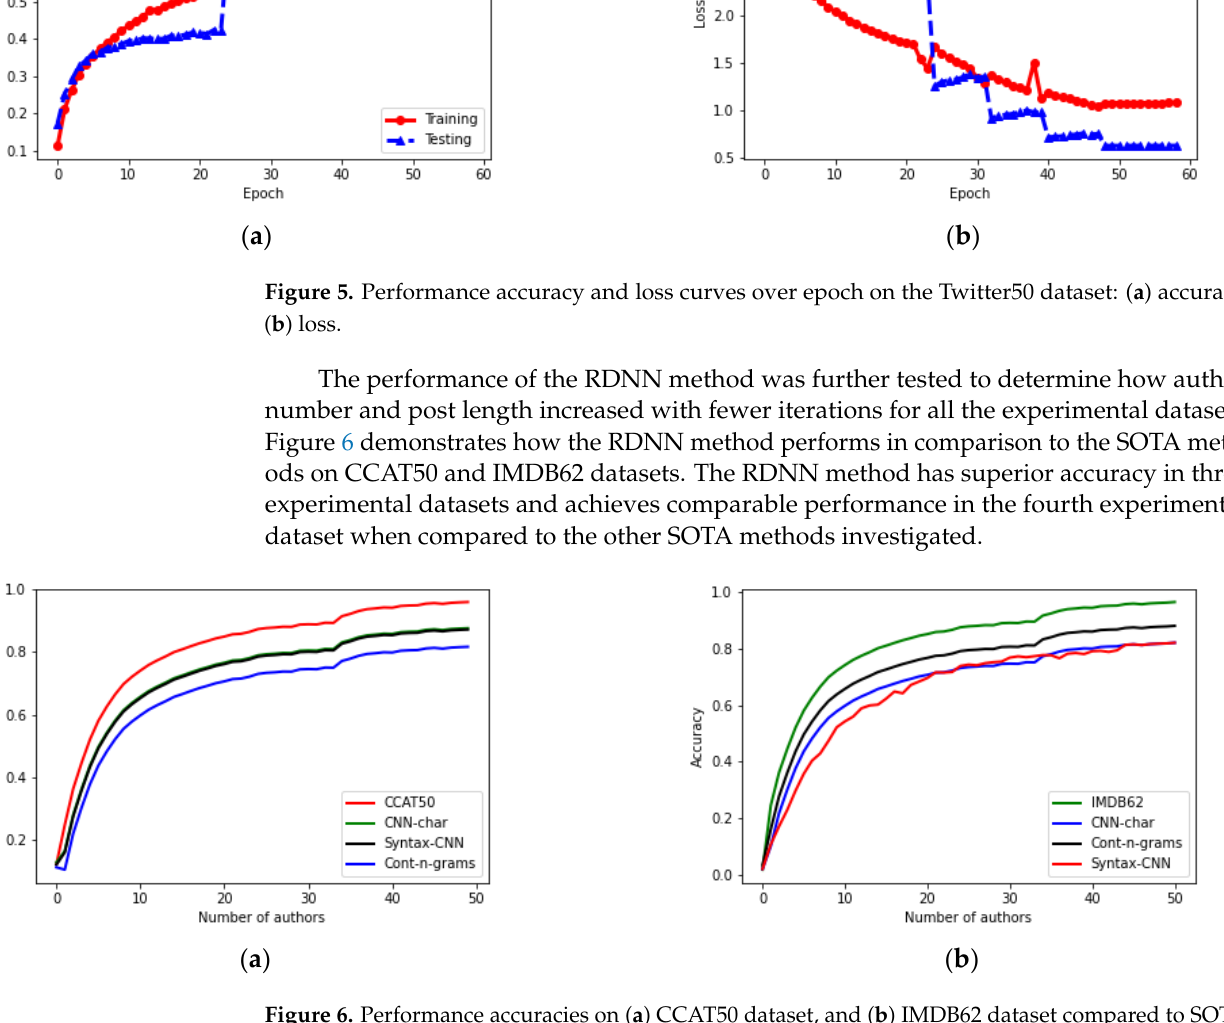
SOTA methods with varying numbers of authors. methods with varying numbers of authors.